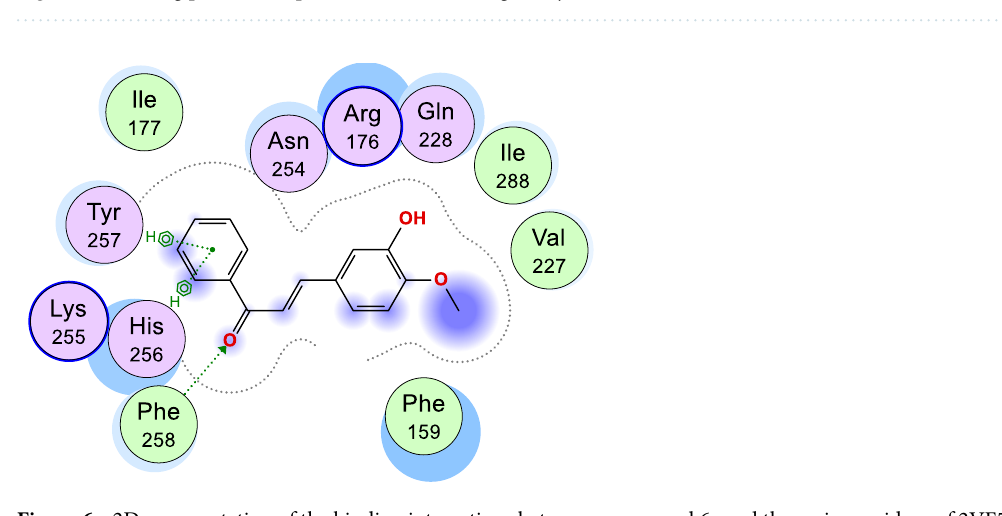
Figure 5. Binding pose of compound 6e in the binding cavity of 1WS3.